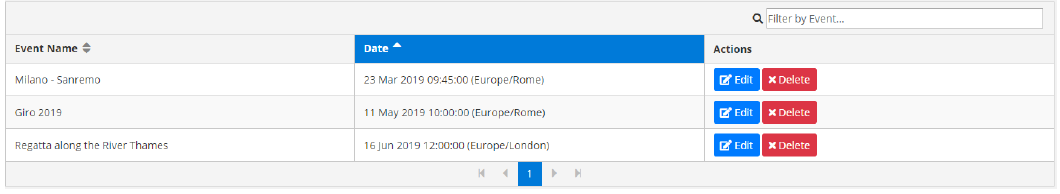
Figure 4. Example screenshot of the event management page.